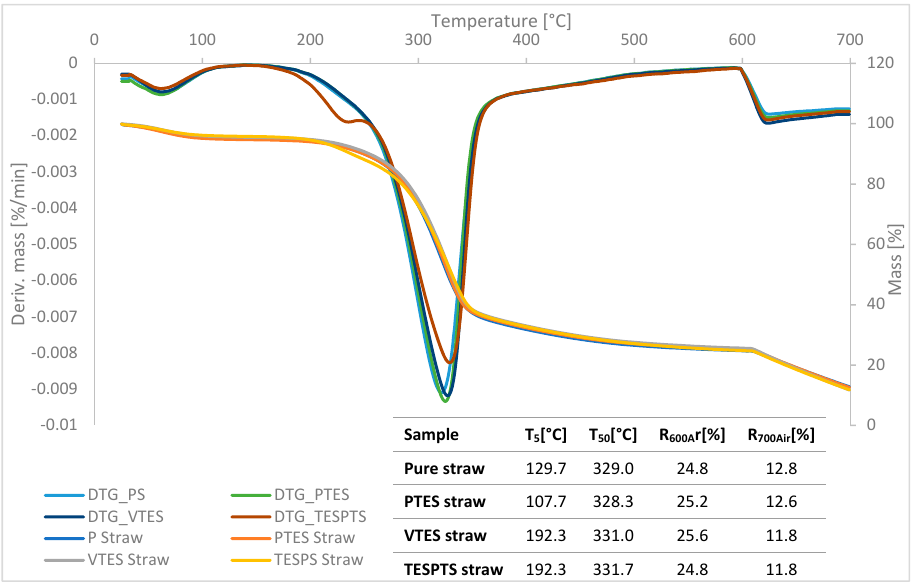
Figure 2. The TGA curves and the first derivative of the TGA curves (DTG curves) of modified and unmodified straw fibers.